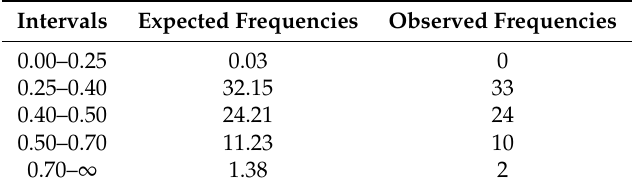
Table 8. Expected frequencies and observed frequencies for modified Data Set 1 when fitting the inverse Weibull model.